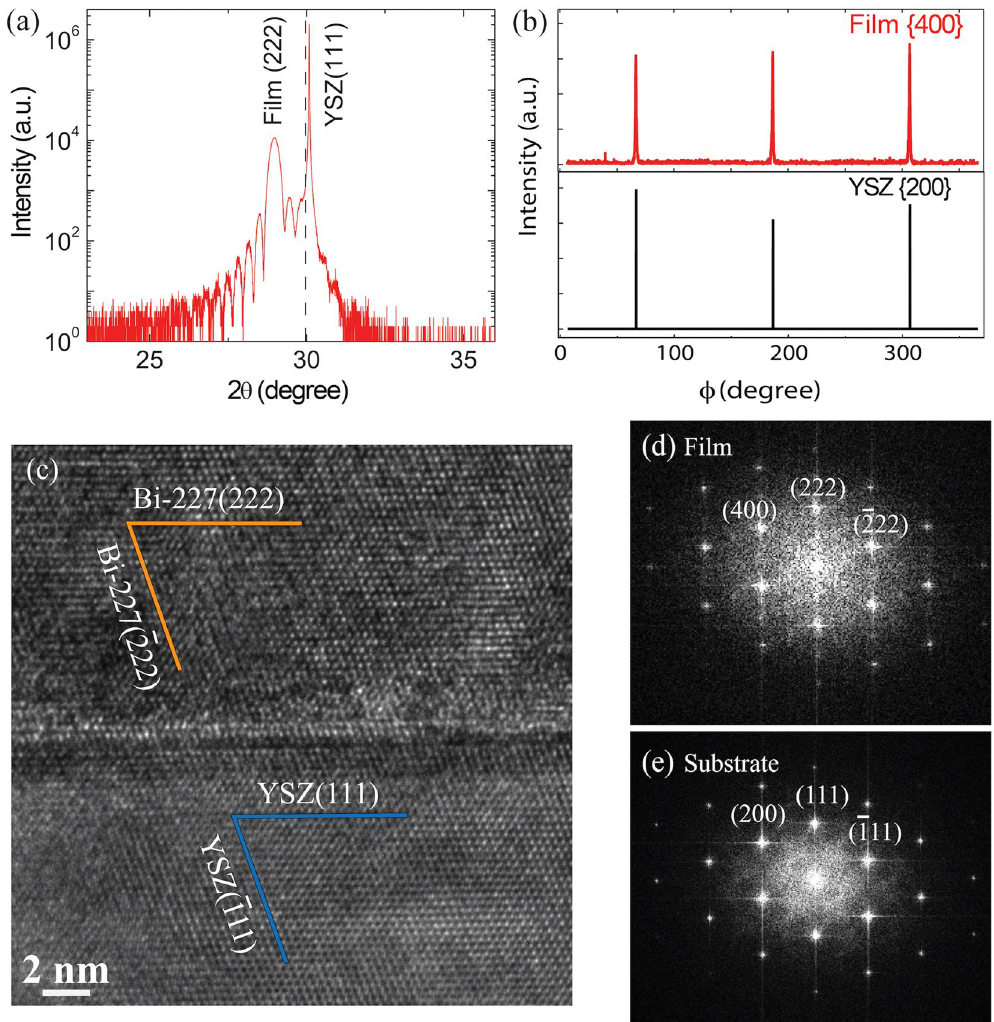
Figure 1. X-ray diffraction characterizations and TEM studies of a representative Bi-227 thin film grown at P O2 = 50 mTorr using Ir/Bi@1 target (f1): ( a ) 2 θ - ω scan around YSZ (111) reflection showing the (111) and (222) peaks of the substrate and thin film, respectively. The dashed line indicates the (222) peak position of the bulk single crystal Bi-227 14, 29 . ( b ) in-plane ϕ -scan for the {200} of YSZ substrate and the {400} of thin film. ( c ) Cross- sectional TEM image taken at the interface of thin film and substrate; Fast Fourier Transform images from ( d ) thin film and ( e )